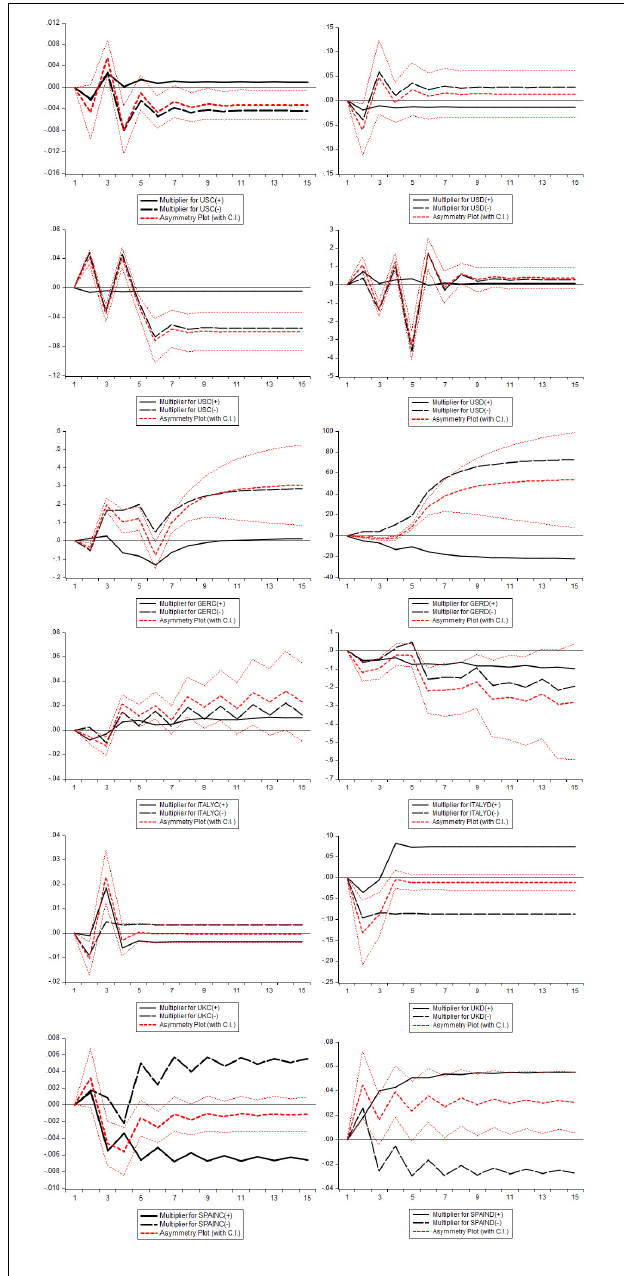
FIGURE 3 | The dynamic multiplier